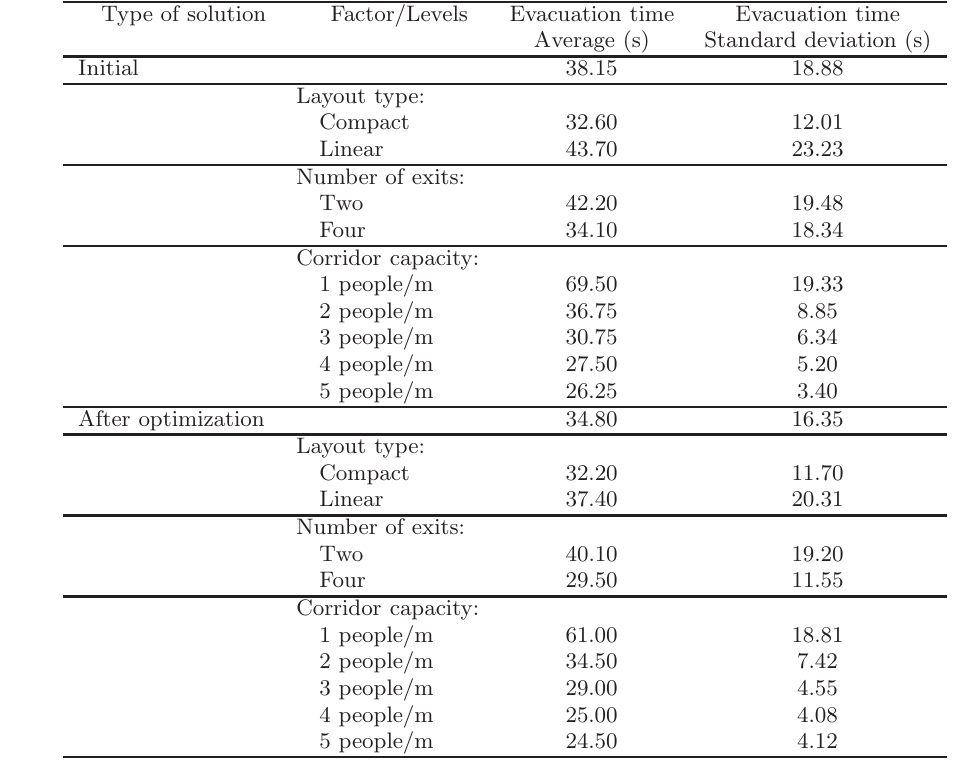
Table 3. Descriptive statistics of the variables involved in the